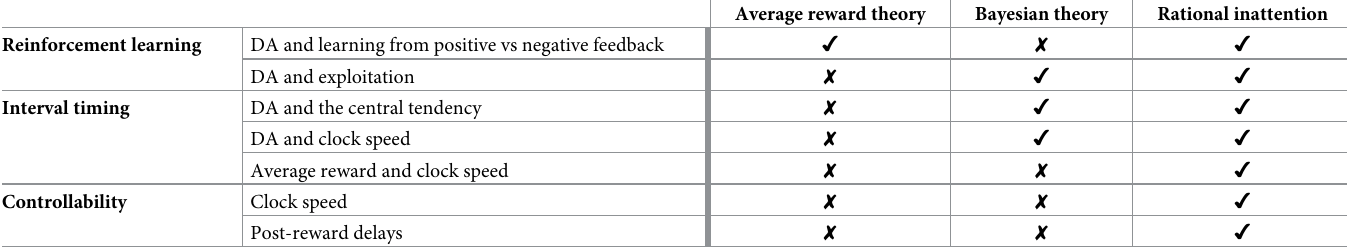
Table 1. Summary of predicted phenomena by theory. The average reward theory is successful when controllability, DA, or average reward is manipulated, and DA or the reward estimate is measured. The Bayesian theory is successful when DA is manipulated, and behavior is measured. The rational inattention framework is successful with any combination of these